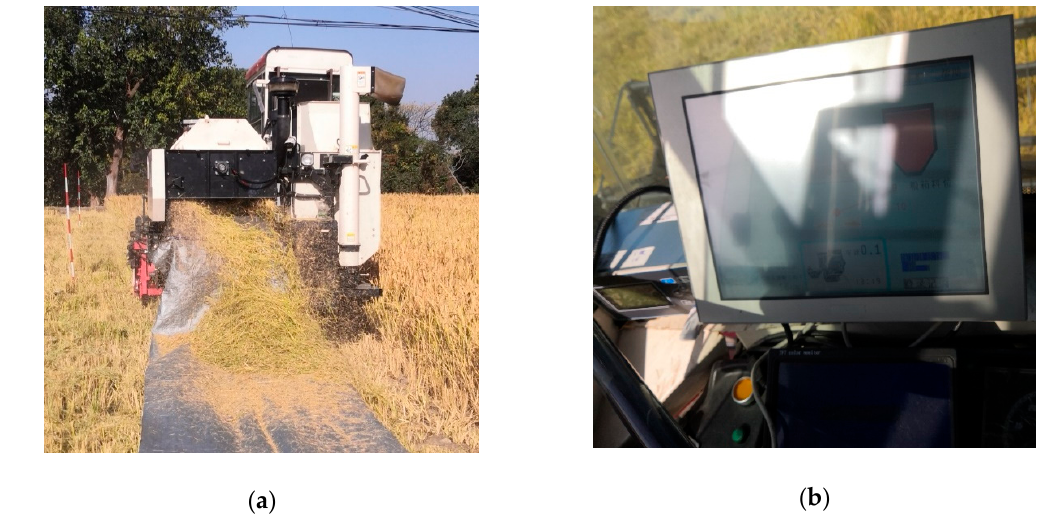
Figure 6. Field experiment of combine harvester: ( a ) Mixture of the threshed output from the combine harvester fell o ff on the oil cloth to catch the material; ( b ) Monitoring system for threshing performance and threshing